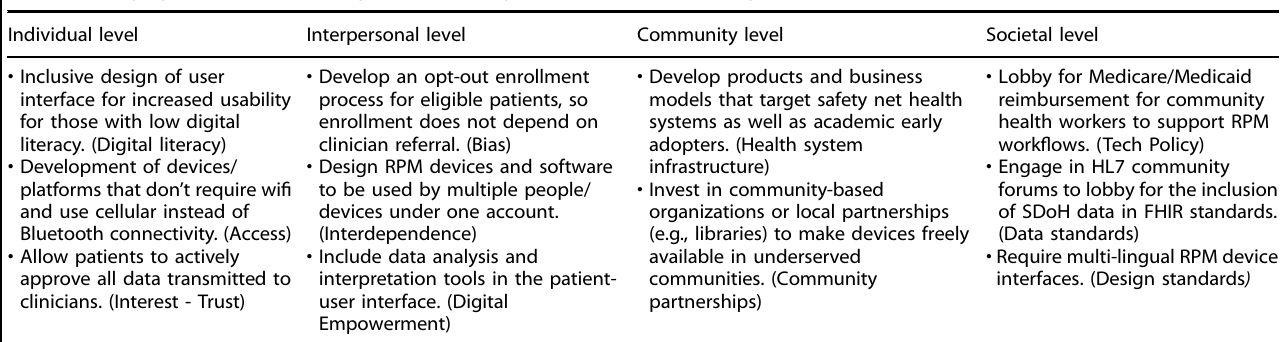
Table 1. Applying the framework for digital health equity: remote patient monitoring use case. Individual